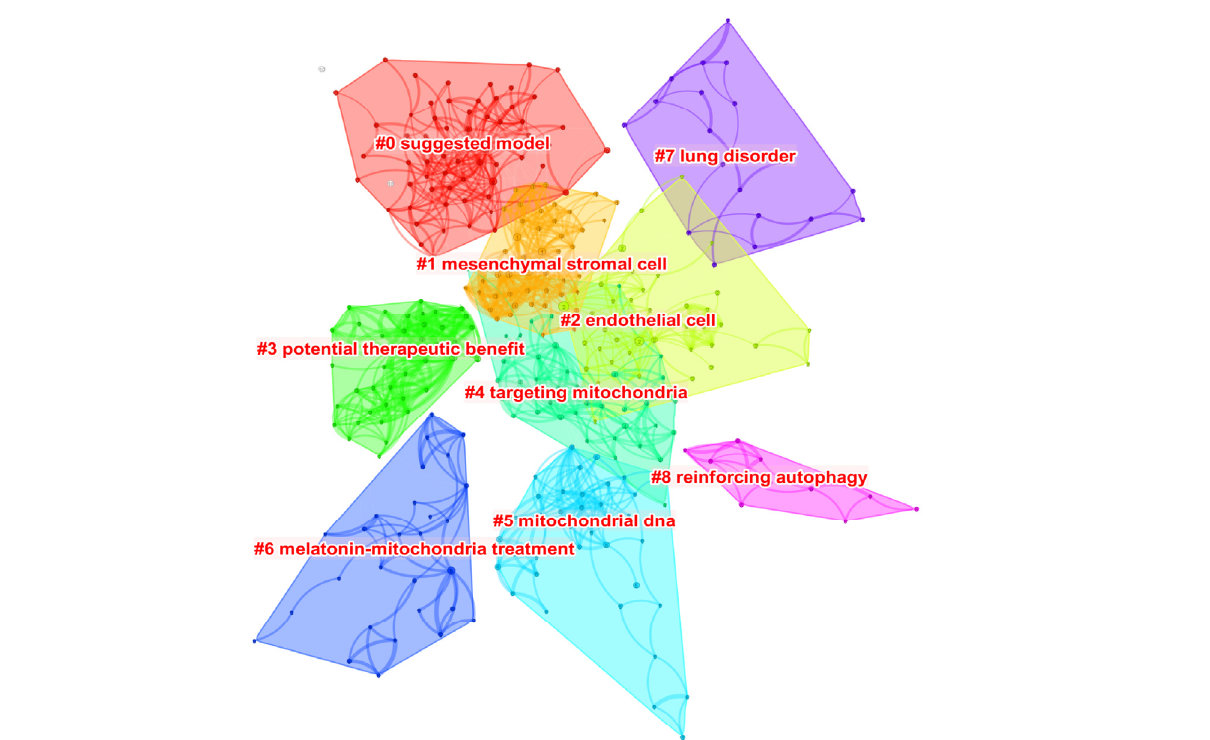
Figure 7. ( A ) The clustered network map of co-cited references related to mitochondria in ALI. Note: Each node represents a reference, and different colors represent different clusters. ( B ) The timeline view of co-citation clusters with their cluster-labels on the right. Note: Each node represents a ref- erence, the size of the circle represents the citation frequency, and the red color of the circles and the connecting curves represents the latest year. 3.8. Burst Detection A citation burst is a sudden increase in the number of citations during a short period, and burst detection reveals the most active areas and emerging trends in the network.